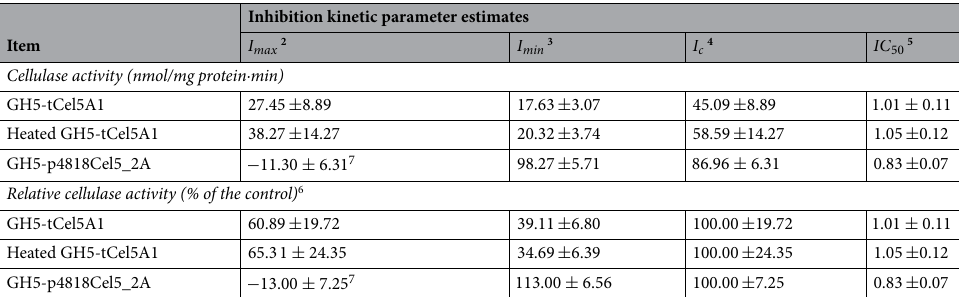
Table 1. Comparative summary of the Experiment-2 in vitro inhibition kinetics 1 of GH5-tCel5A1, the heat-treated GH5-tCel5A1 and GH5-p4818Cel5_2A under the gastric acidic pH of 3.5 obtained through the Eadie-Hofstee linear regression analyses. 1 Values are parameter estimates or means ± SE (n = 72) obtained through the Eadie-Hofstee regression linear analyses, representing the inhibition kinetic parameter estimates obtained from the three gastric acidic pH 3.5 inhibition experiments with 4 replicates per time point in each experiment, as shown in Figs. 6, 7 and 8. 2 I max is the maximal magnitude of inhibition in the cellulase activity (nmol/mg protein·min or % of the control, I c ; means ± SE, n = 12) calculated according to Eq. (2). 3 I min is the minimal residual cellulase activity (nmol/mg protein·min or % of the control, I c ; parameter estimate ± SE, n = 72) under the acidic pH 3.5 inhibition condition obtained from Eq. (1). 4 I c is the mean cellulase activity of the control group (nmol/mg protein·min or % of the control, means ± SE, n = 12). 5 IC 50 is the incubation time (h, parameter estimate ± SE, n = 72) required to reach the half maximal inhibition of the cellulase activity. 6 Relative cellulase activity (%, means ± SE, n = 12) calculated as percentage of the control group ( I at 0-min exposure to the gastric pH-3.5 incubation. 7 I max value was non-significant from 0 ( P > 0.05) as compared by the pooled